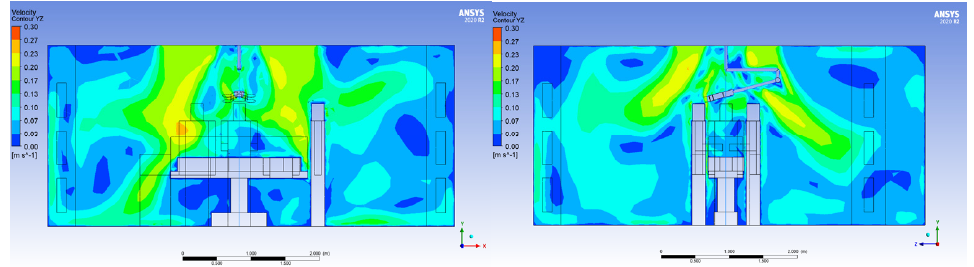
Figure 8. Air velocity profiles for variant 2 on the XY plane ( left ) and YZ ( right ).